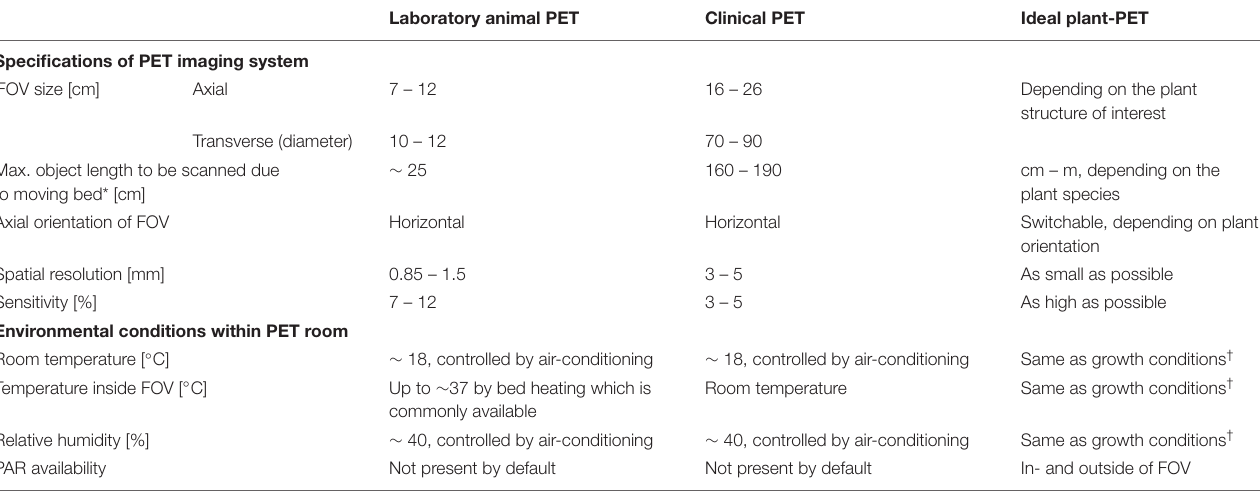
TABLE 2 | Generalized specifications of laboratory animal and clinical PET imaging systems as well as for the ideal plant-PET system. Additionally, environmental conditions within the PET room, which are of relevance in plant science, are listed. Laboratory animal PET Clinical PET Ideal